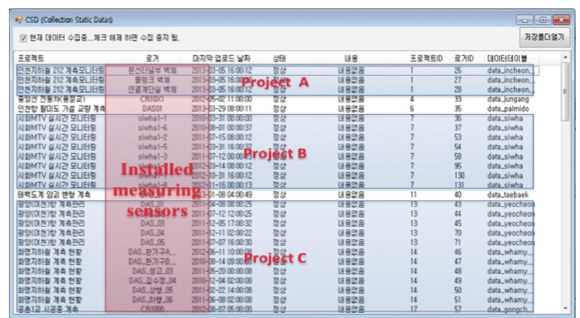
Figure 4: Collection static data program.